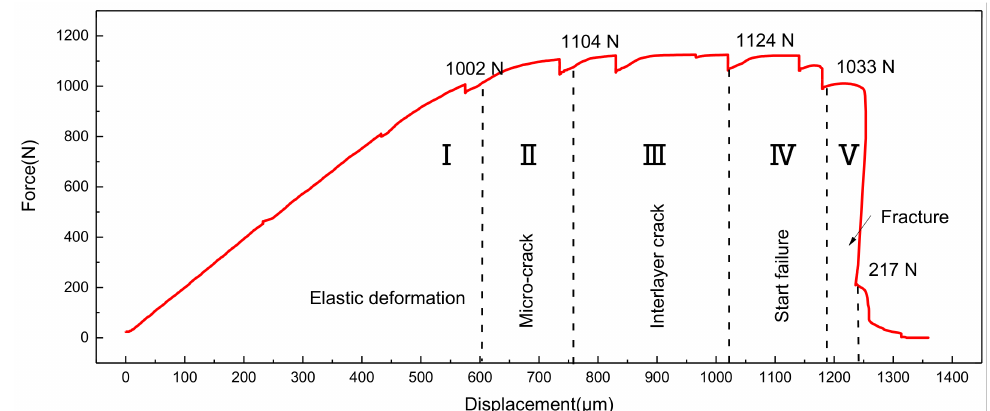
Figure 12. Force–displacement curve of SiC f -reinforced Ti/Ti–Al laminate composite under in situ tensile testing.